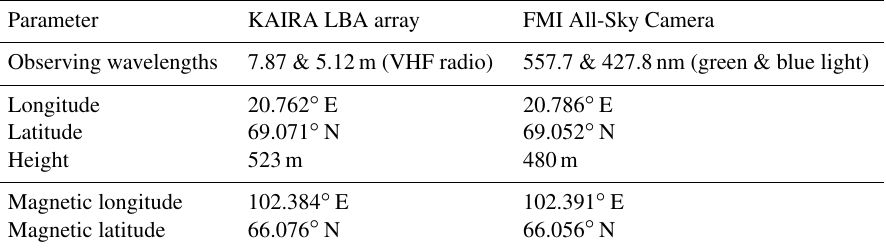
Table 1. Parameters for the instruments used. Magnetic coordinates were calculated using aacgmv2 Python libraries for the epoch 20 De- cember 2016. The FMI-ASC altitude was estimated from NLS karttapaikka